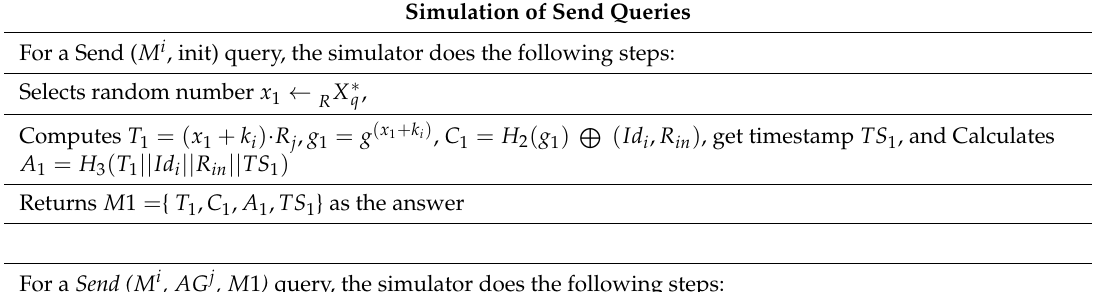
Table 12. Simulation of send queries. Simulation of Send